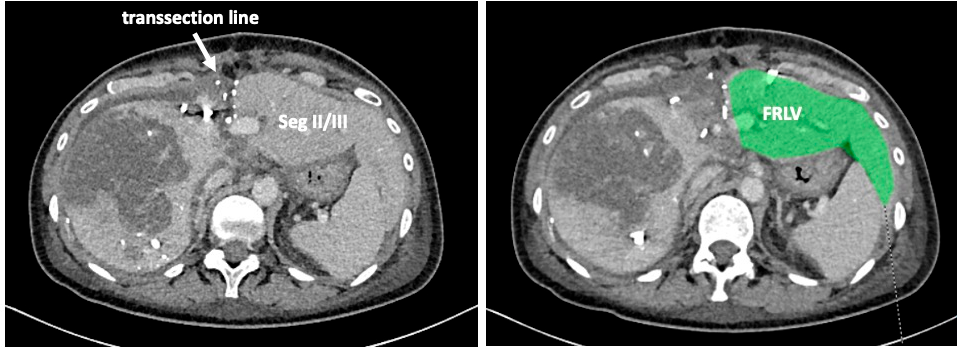
Figure 6. The functional residual liver volume (FRLV) is measured on a weekly basis until a sufficient volume is reached.